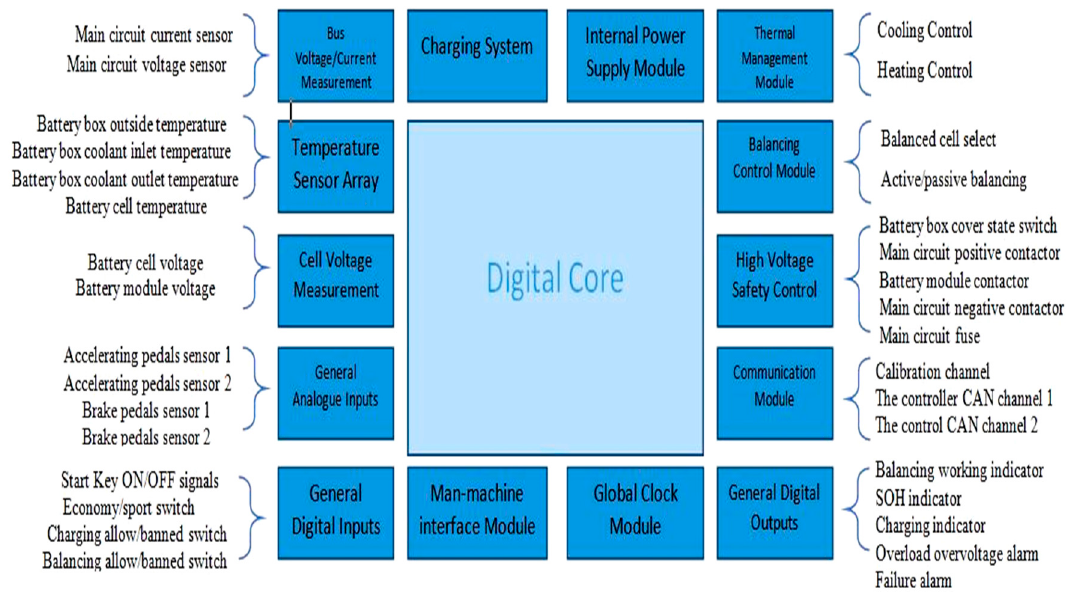
Figure 2. Basic framework (software & hardware) of a BMS. Adapted from [18].